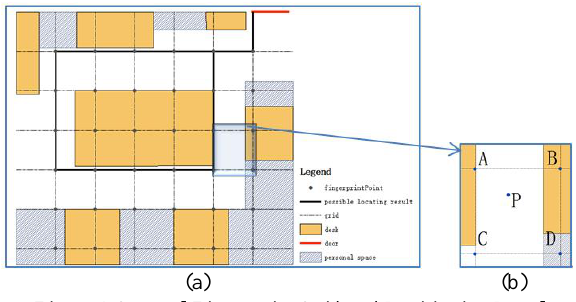
Figure 1 General Fingerprint Grid and Positioning